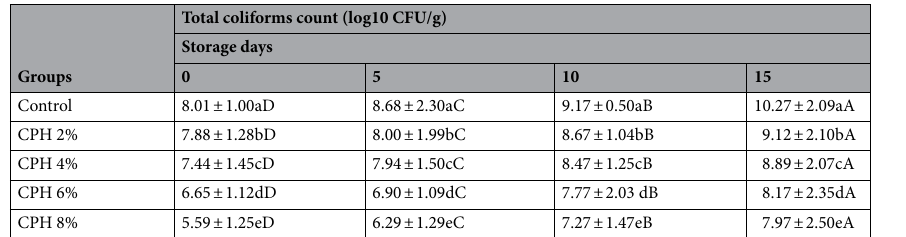
Table 8. Total coliforms count (TCC) of casein protein hydrolysate (CPH) powder incorporated raw beef nuggets. CPH: casein protein hydrolysate. All the values are means of triplicate determinations ± Standard Deviation (SD). Means within the column with different small letters are significantly different (p < 0.05) and different capital letters within the row differed significantly.